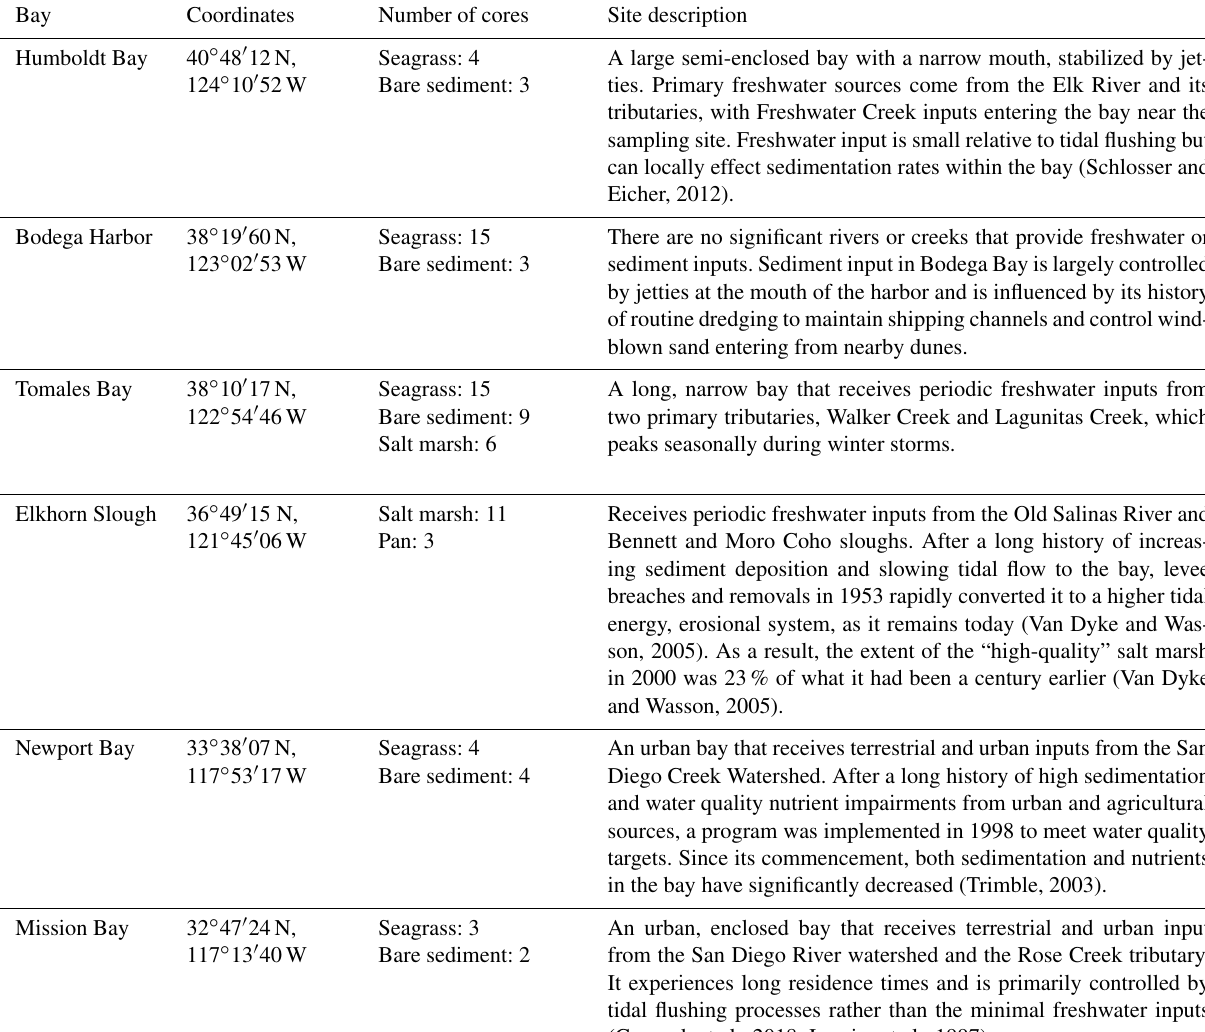
Table 1. Location and brief description of each bay sampled in this study, along with the total number of cores collected from each habitat type in each of these